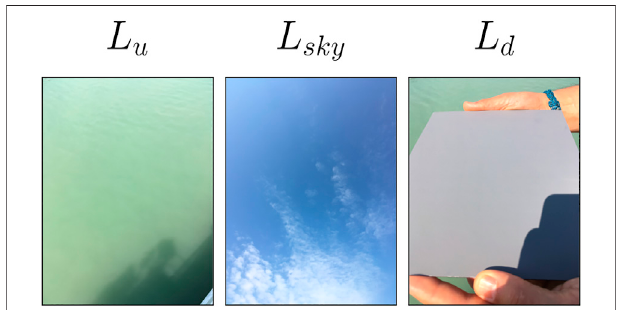
FIGURE1| ExampleiPhoneSEimagesof L u , L sky ,and L d ,takenatLake Balaton on 3 July 2019 at 07:47 UTC (09:47 local time). Little wave motion is visibleonthewatersurfacein L u ,while L sky showspatchycloudcoverage.The conditions seen here were representative for the entire